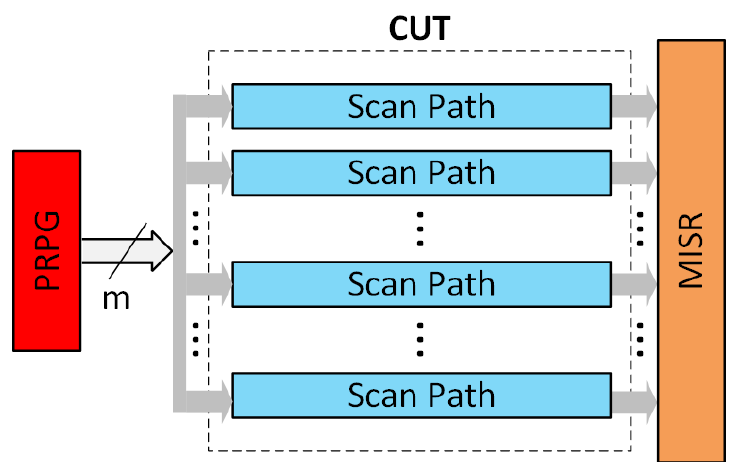
Figure 1. An LBIST module with the classic STUMPS